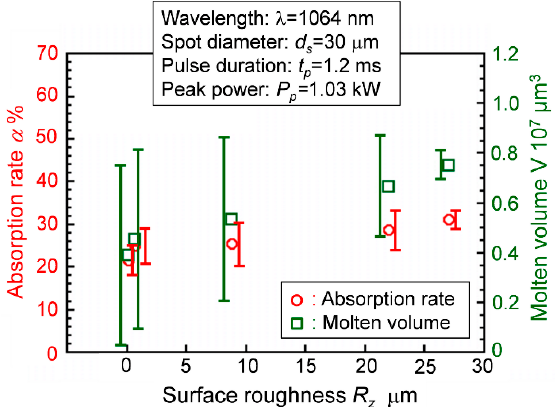
Figure 11. Variations of absorption rate and molten volume with roughness under transitional processing condition between heat conduction and keyhole welding modes.